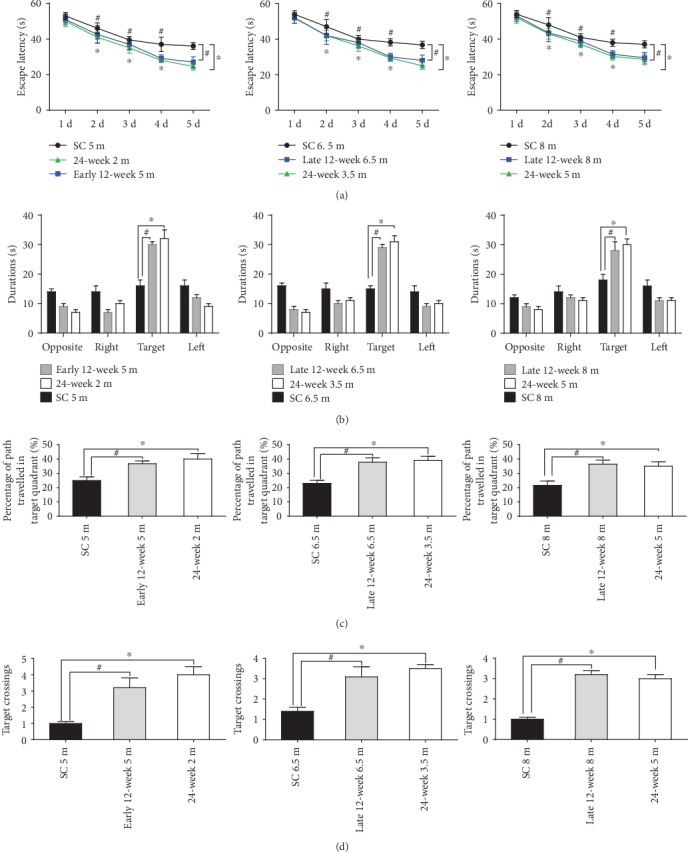
Effects on MWM spatial memory of different exercise durations. In the hidden platform test, the escape latencies (a) of APP/PS1 mice that were the same age at the end of the observation period were collected and analyzed. In the probe test, durations in the target quadrant (b), percentage of path traveled in the target quadrant (c), and number of target crossings (d) were compared. SC: sedentary control; TE: treadmill exercise. #SC vs. 12-week exercise group, P < 0.05; ∗SC vs. 24-week exercise group, P < 0.05.